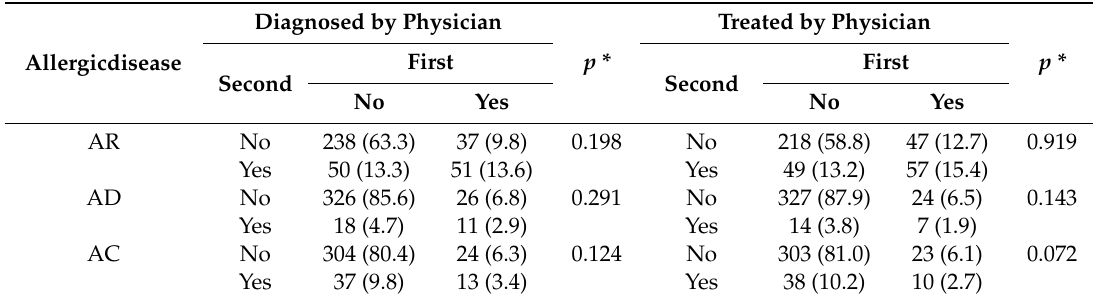
Table 2. Comparison of individual changes in the prevalence of allergic diseases during the first and second survey.